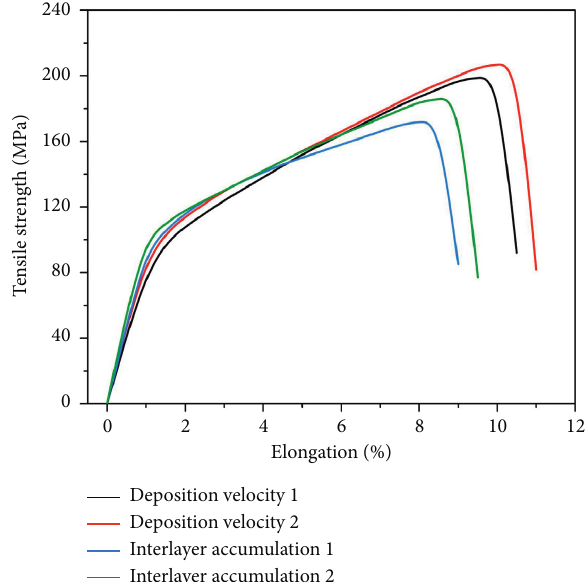
Figure 14: Tensile curves of the deposition wall in the direction of the deposition velocity and interlayer accumulation with the copper plates constrained